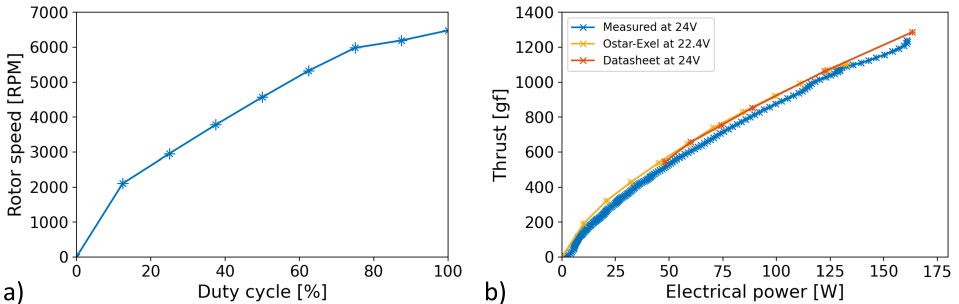
Figure 4. ( a ) Rotor speeds at different duty cycle values, and ( b ) validation of experimental setup by comparing measurements with published results